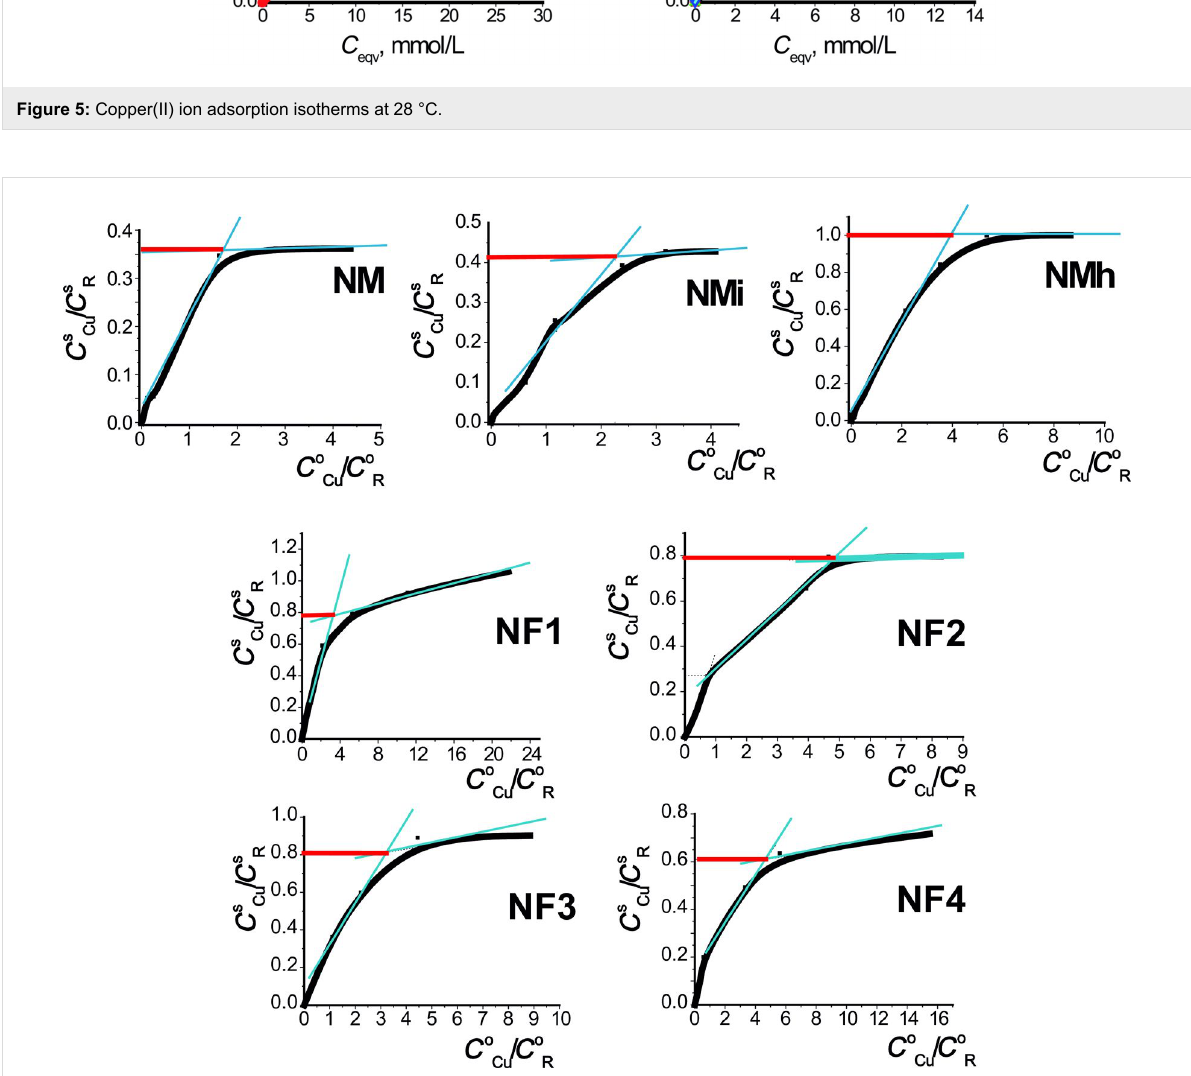
Figure 6: The molar ratio of copper(II)/aminopropyl groups in the surface of the microspheres as a function of that ratio in the initial solution.